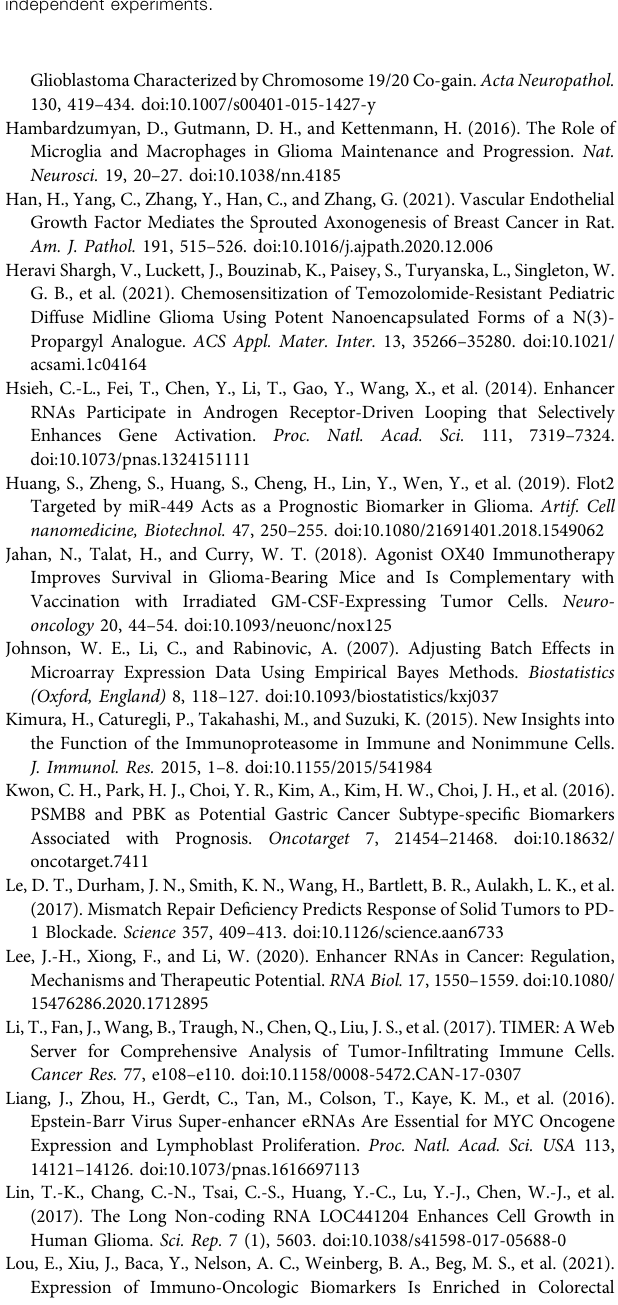
Supplementary Figure S4 | PD-L1 and CTLA-4 comparison. (A-D) comparison between LGGs and GBM; (E-F) comparison between high-risk and low-risk patients withtumourgradeIII; (G-H) comparisonbetweenhigh-riskandlow-riskpatientswithGBM. Supplementary Figure S5 | GSVA analysis. (A) The heatmap of GSVA result. (B) Differential pathways. Supplementary Figure S6 | Proportional hazards test fi gure. SupplementaryFigureS7| Nomograminsubclasspatients. (A-D) Thecalibration, ROC curves, and Kaplan-Meier curve in the TCGA cohort. (E-F) The calibration, ROC curves, and Kaplan-Meier curve in the CGGA cohort. Supplementary Figure S8 | The comparison of genomic alterations. (A) Chr 7+/ 10-; (B) MGMT methylation; and (C) TERT gene expression. Supplementary Figure S9 | The gene expression pro fi le of the CGGA cohort.